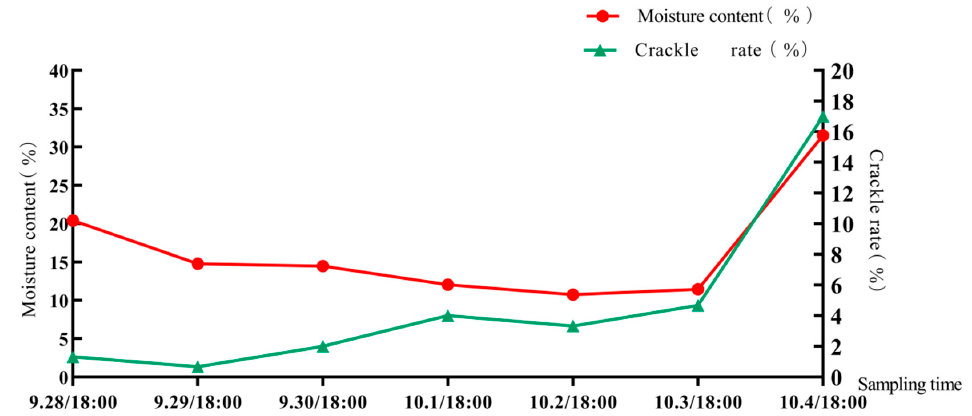
Figure 8. Cracking rates of rice before and after rainfall events during the baling and drying test.